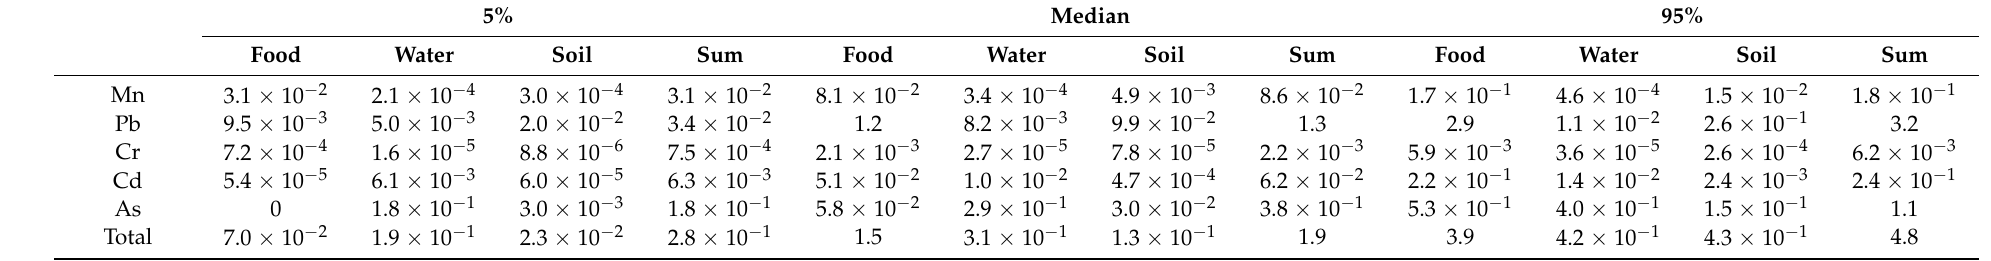
Table 4. Summary of the Hazard Index of the metal(loid)s found in duplicates of diet, water, and soil samples ingested by children at the 5th, median, and 95th percentiles. 5% Median 95% Food Water Soil Sum Food Water Soil Sum Food Water Soil